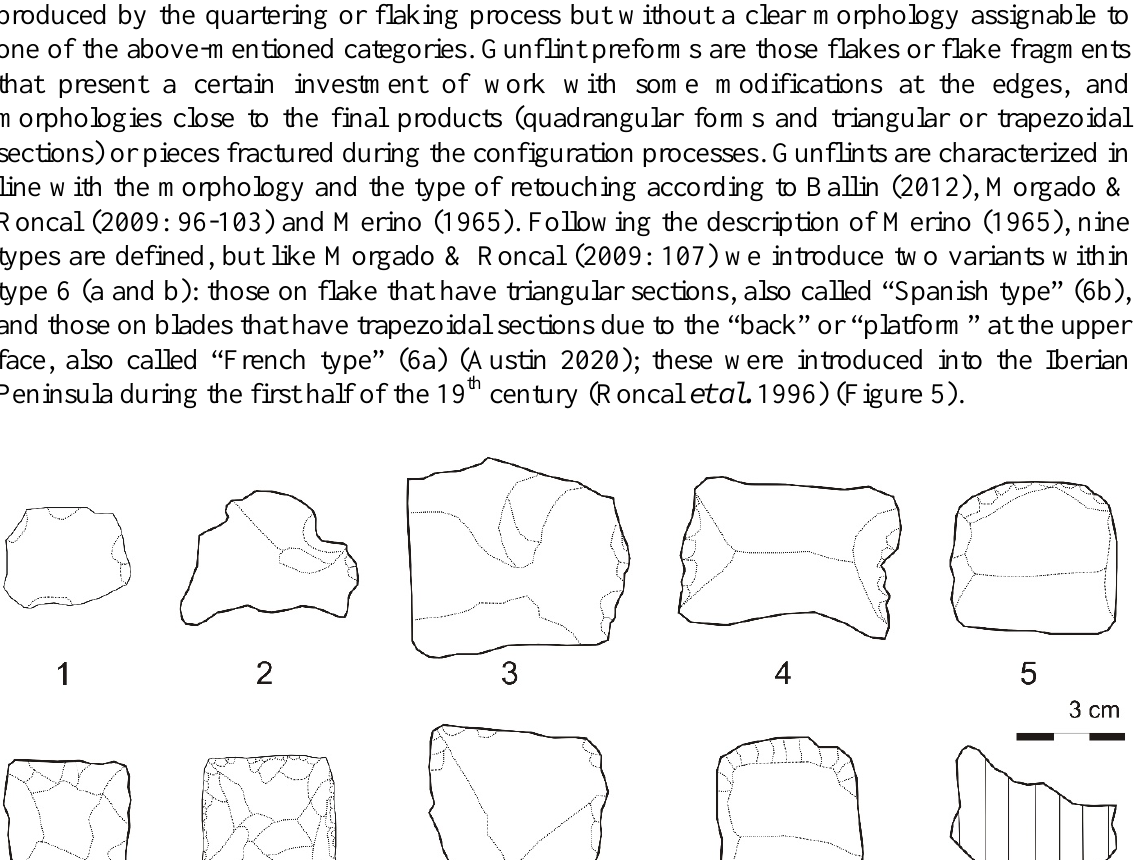
blades those whose length is twice the width, and as microblades those whose width is less than 8 mm. For the carination index, we follow Laplace (1972), dividing the smallest of the flat dimensions (length or width) by its thickness. A carinated object offers indexes lower than 2.23, and flat artefacts exceed this